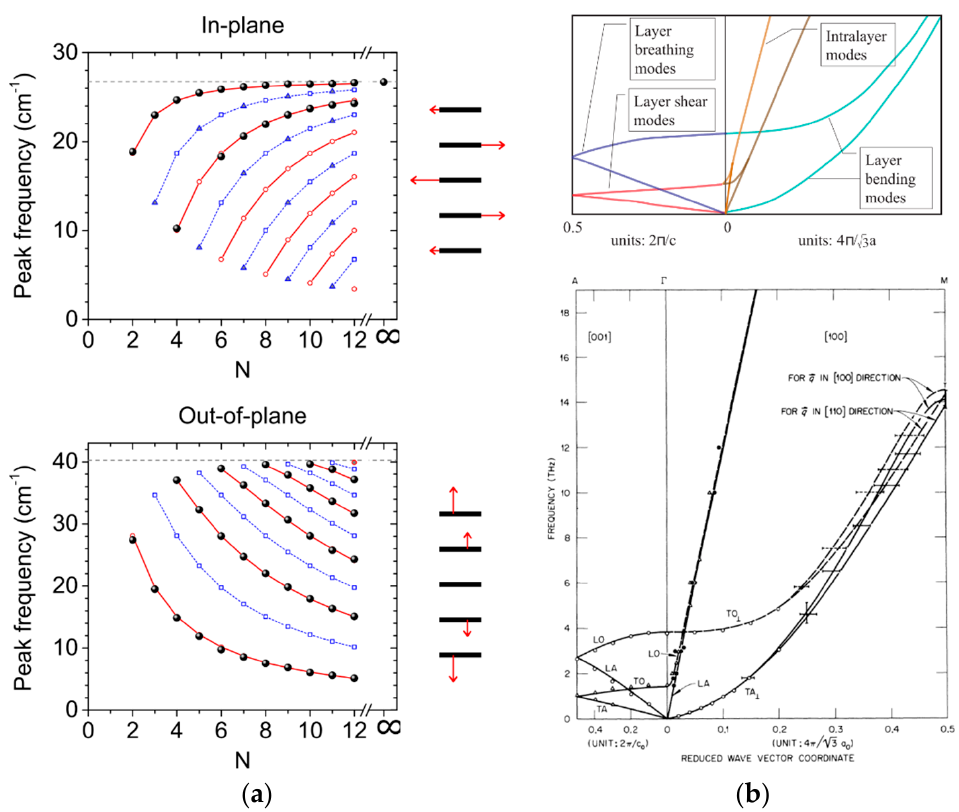
Figure 2. ( a ) Energy of the Raman-active interlayer phonon modes, (top) shear and (bottom) breathing, as function of the number of layers in MoTe 2 . Schematics of the displacement of each prominent mode is shown in the five-layer case. Adapted from [52], with permission from American Chemical Society, Copyright © 2015. ( b ) (top) Phonon dispersion schematic for layered materials. From [62] © IOP Publishing. Reproduced with permission. All rights reserved. (bottom) Experimental phonon dispersion from inelastic-neutron-scattering spectroscopy in graphite. Reprinted with permission from [63], Copyright © 1972 by the American Physical Society.